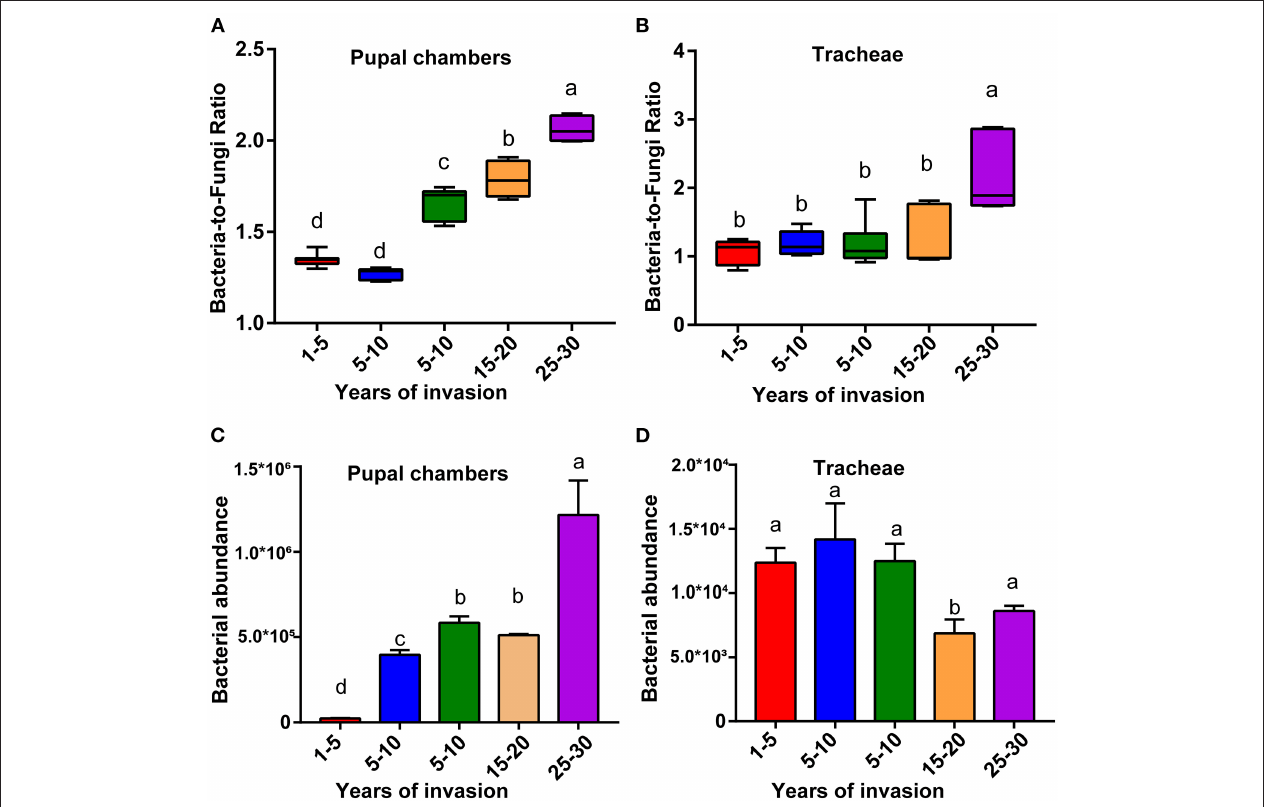
FIGURE 2 | The relative bacterial and fungal abundance of pupal chambers and tracheae in sites differing in the duration of PWN invasion. The bacteria-to-fungi ratio of pupal chambers (A) and tracheae (B) samples in sites differing in the duration of PWN invasion (years of invasion in the X-axis). The total bacteria content of pupal chamber (C) and tracheae (D) samples from different sites differed in the duration of PWN Sinvasion. The abundance of bacterial and fungal biomass was estimated by RT-qPCR. Different letters indicate statistically significant differences from the one-way ANOVA with Tukey’s multiple comparison test, p < 0.05. Data are presented as means ± SEM.